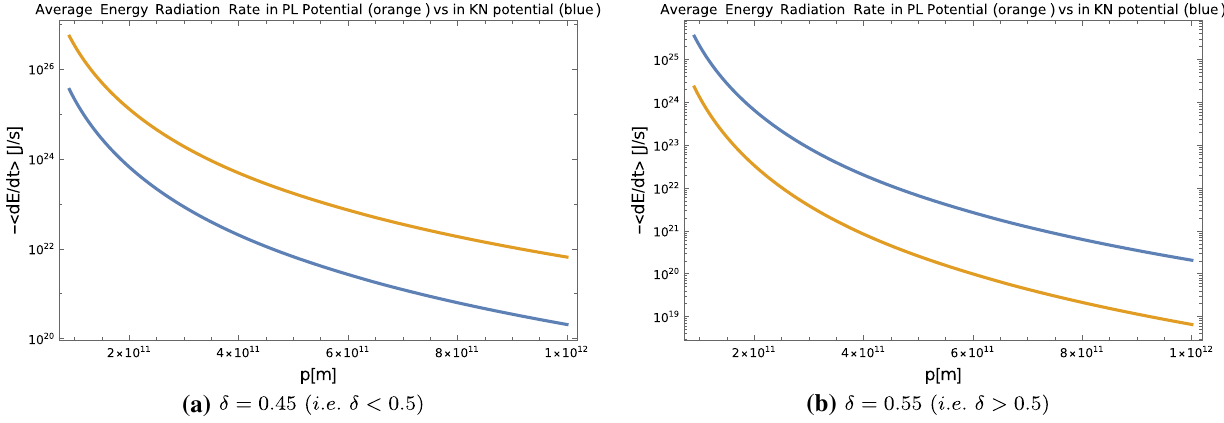
Fig. 2 Figure shows variation of 1-PN corrected rate of energy radi- ation from an extreme mass ratio binary in power law (PL) potential (orange curve) and in Kepler–Newton (KN) potential (blue curve) with